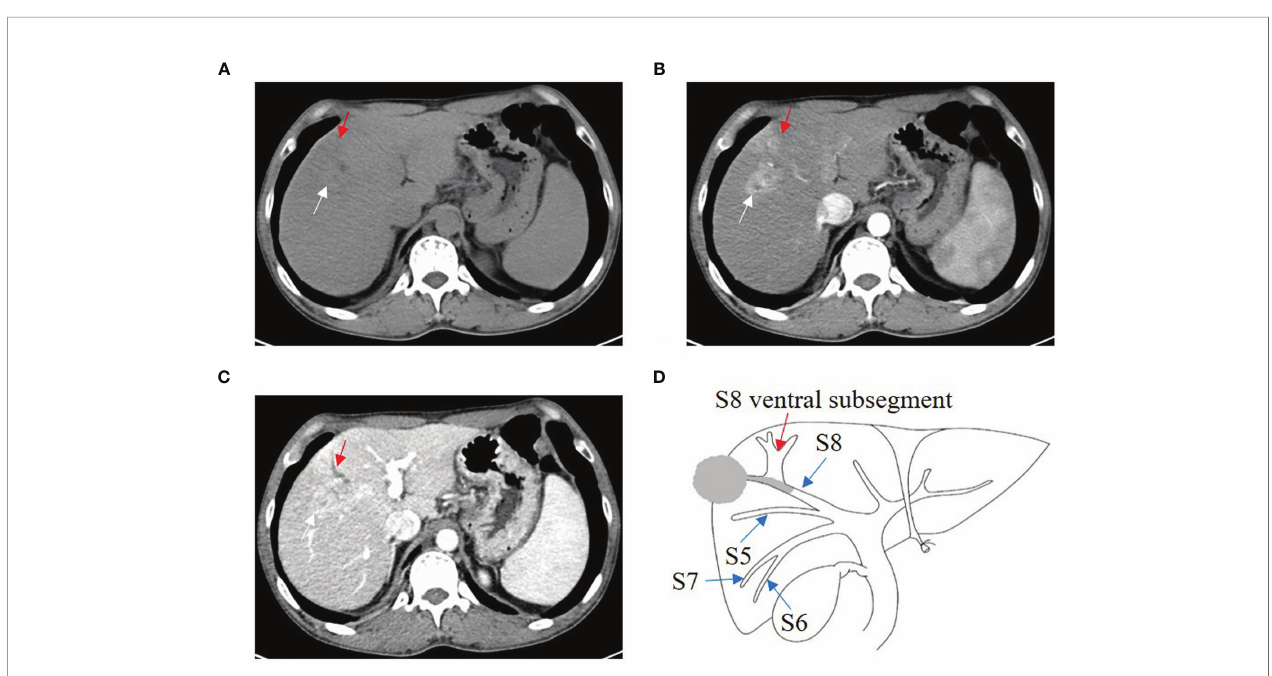
FIGURE 3 | HCC with B1 BDTT. (A) The HCC lesion (white arrow) and bile duct dilation in S8 (red arrow) show hypoattenuation in plain CT image. (B) The HCC lesion has early enhancement (white arrow) in arterial phase, but enhancement of the bile duct dilation (red arrow) was not observed. (C) The HCC lesion (white arrow) shows hypoattenuation at portal venous phase, accompanied by dorsal bile duct dilation (red arrow) in S8. (D) HCC lesion, BDTT, and bile duct dilation (red arrow).